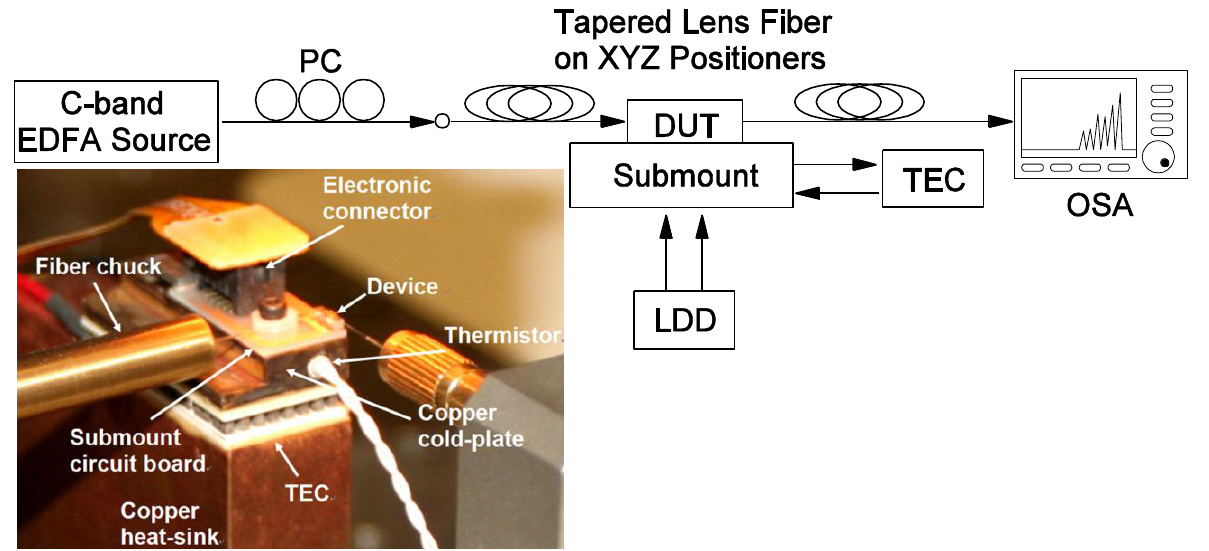
Figure 6. Schematic setup for spectral response measurements of the photonic channelizer devices (EDFA: erbium-doped fiber amplifier, PC: polarization controller, DUT: device under test, LDD: laser diode driver, TEC: thermoelectric cooler, OSA: optical spectrum analyzer). Inset: A custom designed submount and circuit board assembly